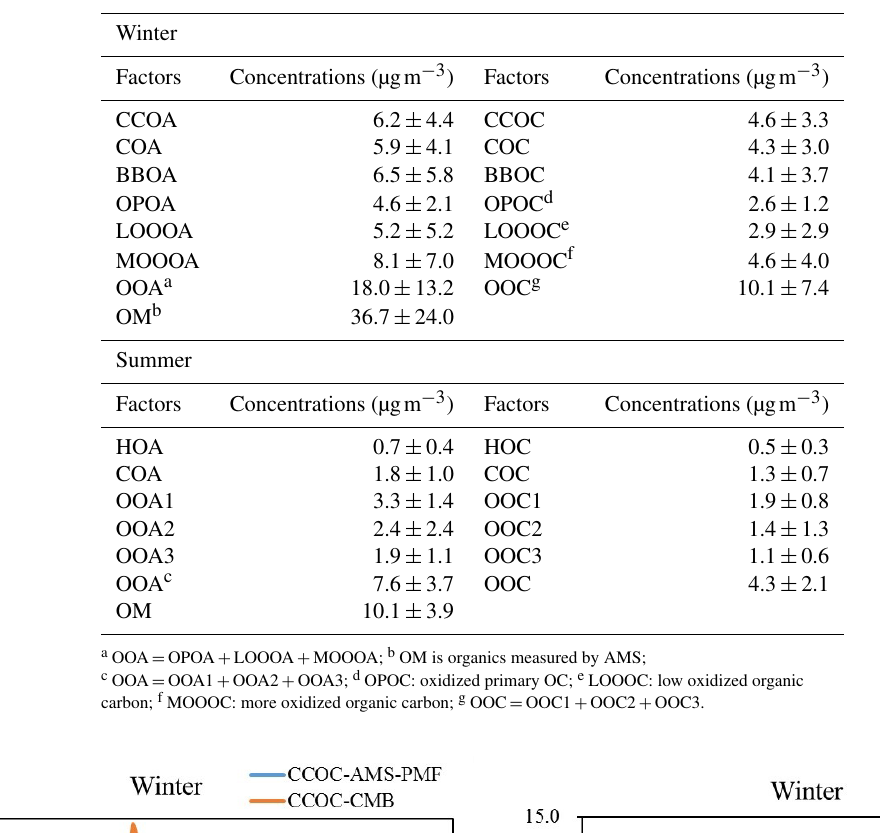
Table 3. Source contributions of OA and OC (µgm − 3 ) from AMS-PMF results in urban Beijing during winter and summer.